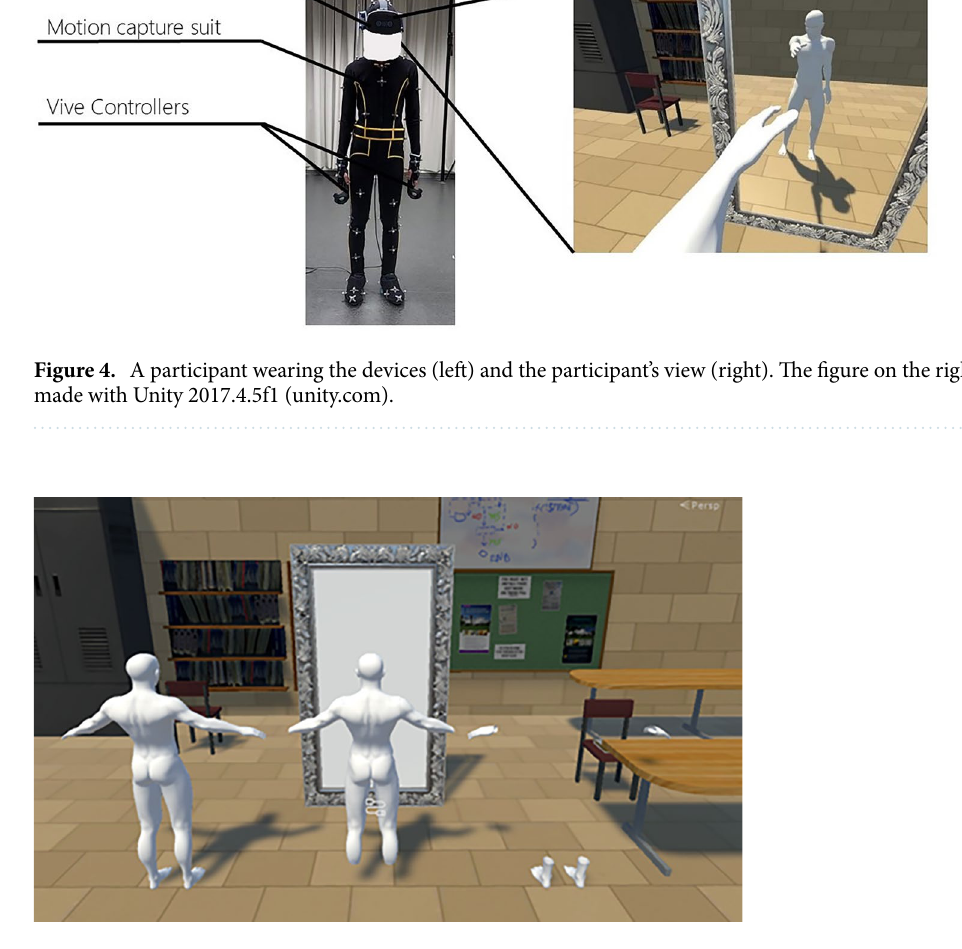
Figure 5. Avatar conditions: complete avatar (left), avatar missing hands and feet (center), avatar hands and feet only (right). The figure was made with Unity 2017.4.5f1